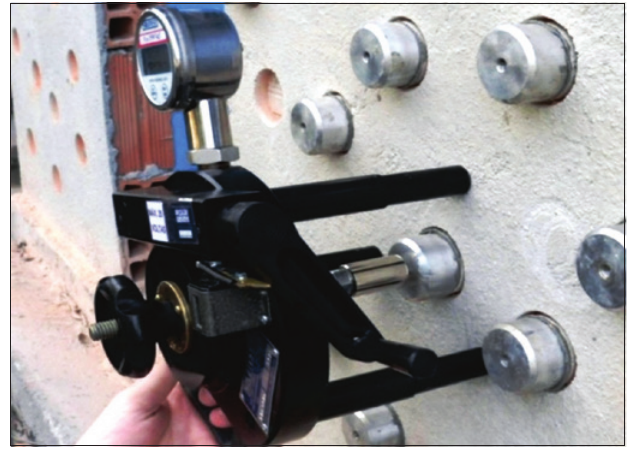
Equipment used in the test of tensile strength in the mortars bonding